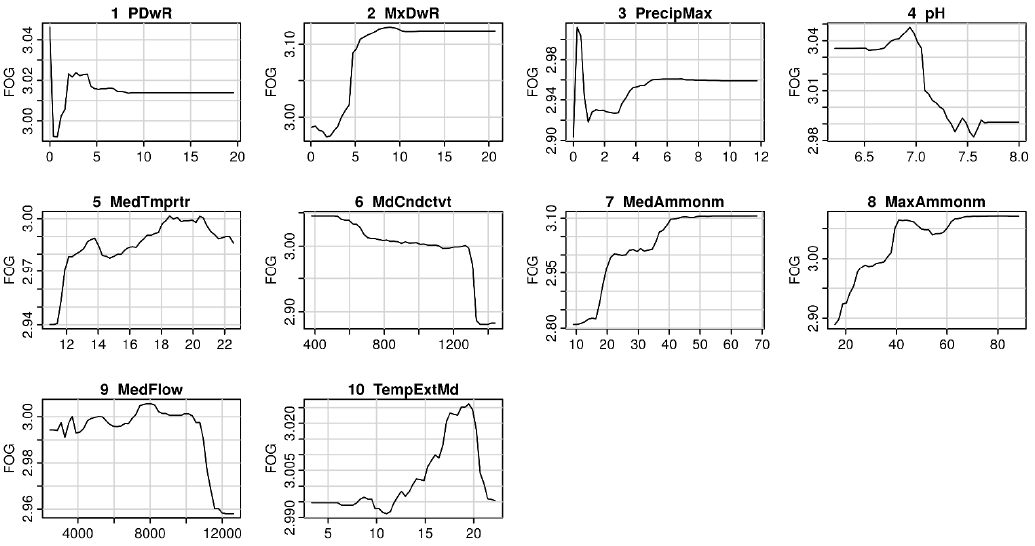
Figure 10. Sensitivity analysis (one variable).